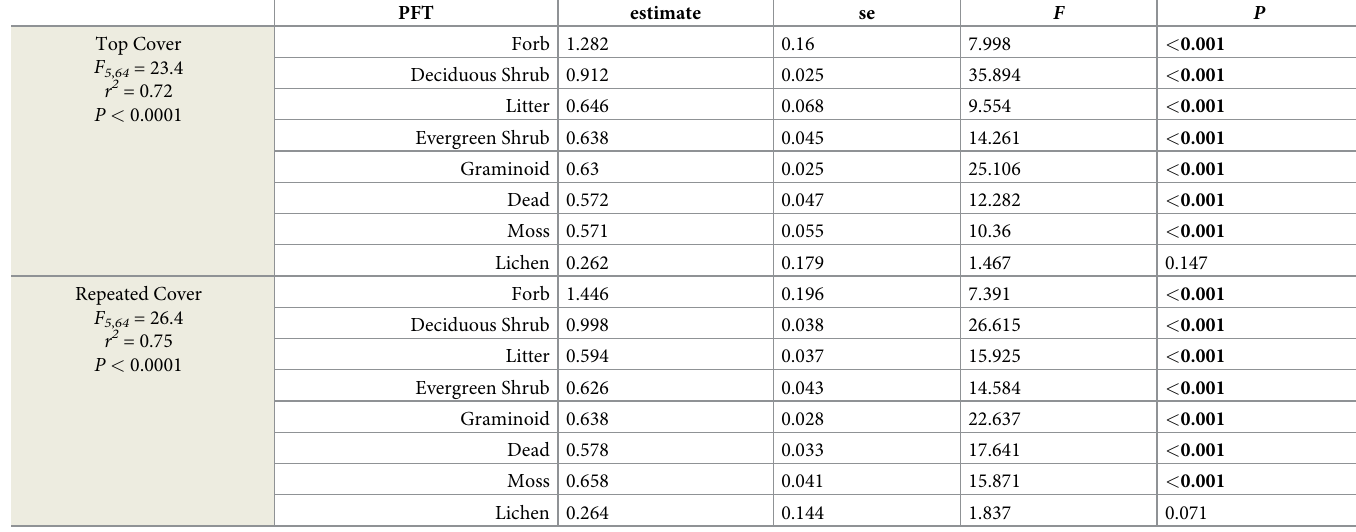
P values in bold indicate significance at the P < 0.05